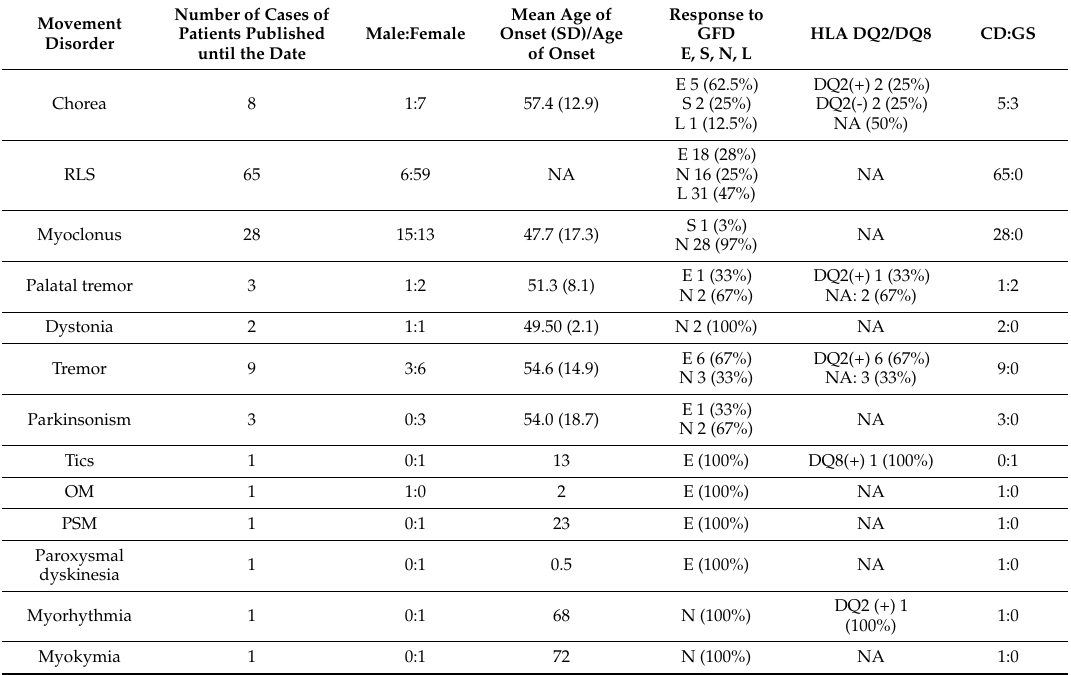
Table 2. Characteristics of the papers included in the